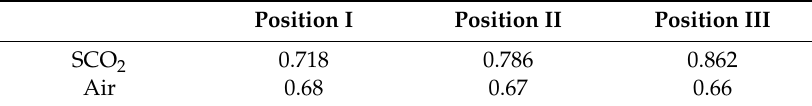
Table 3. Flow discharge coe ffi cient of SCO 2 and air at di ff erent